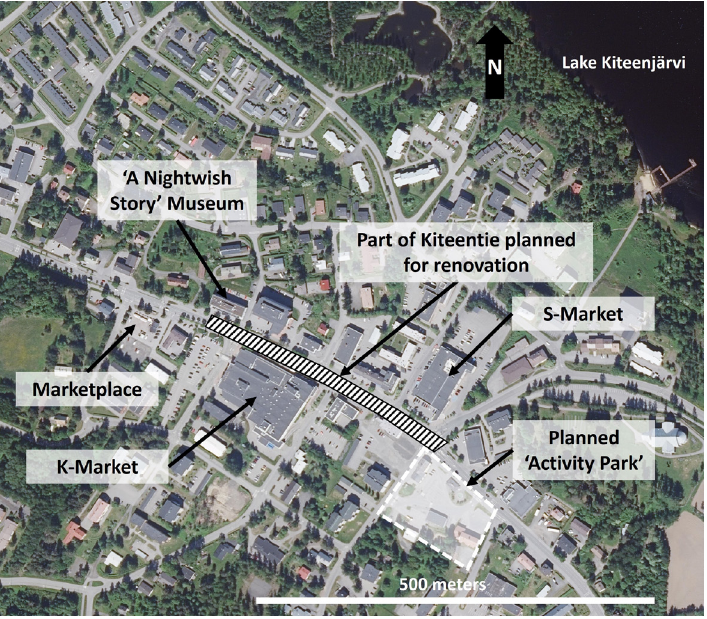
Fig. 3. Planned downtown area in Kitee (Background: Maan- mittauslaitos Ortokuva